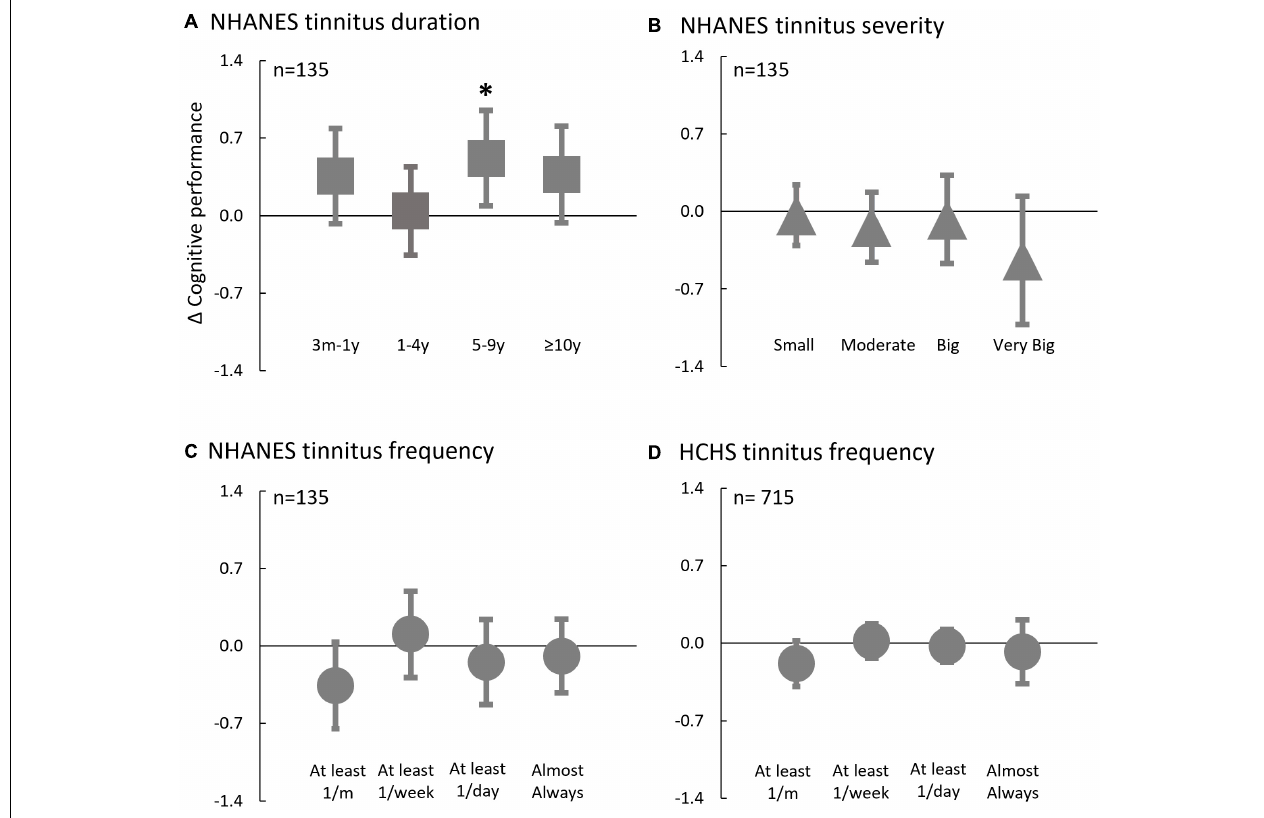
FIGURE 5 | Adjusted Difference in Cognitive Performance Associated with Tinnitus Attributes in NHANES (A–C) and HCHS (D) . Multivariable linear regression models were used in participants with tinnitus to predict the relative difference in cognitive performance to the reference groups based on tinnitus attributes. Reference groups: (A) Tinnitus Duration < 3 m; (B) Tinnitus Severity = No problem; (C,D) Tinnitus Frequency < 1/month; Error bars denote 95% CI. *indicates a significant association between tinnitus factor and cognition and the tinnitus-based category scoring statistically significantly different than the reference group ( p <